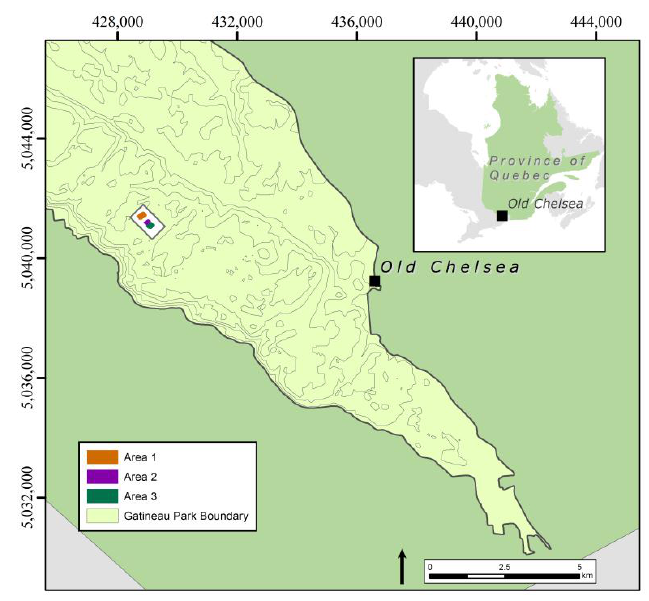
Figure 2. Location of two areas where imagery was acquired for mapping wild leek by means of pre-programmed UAV flights. Two separate flights were conducted, one for each area, on 10 and 11 May 2017. All coordinates refer to WGS 1984, UTM Zone 18N. Other spring species emerge at the same time as wild leek and in similar environments.